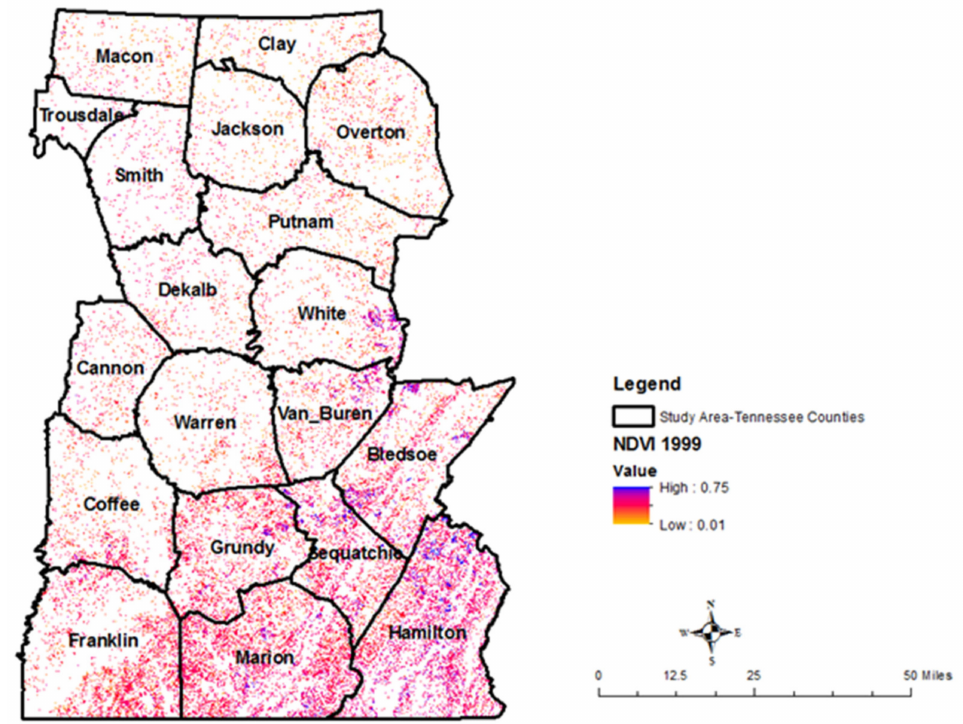
Figure 7. November 1999 NDVI of southern yellow